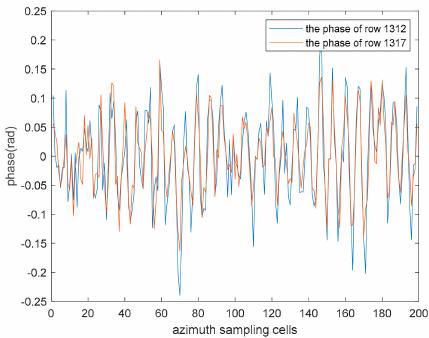
Figure 28. The phase of delay conjugate